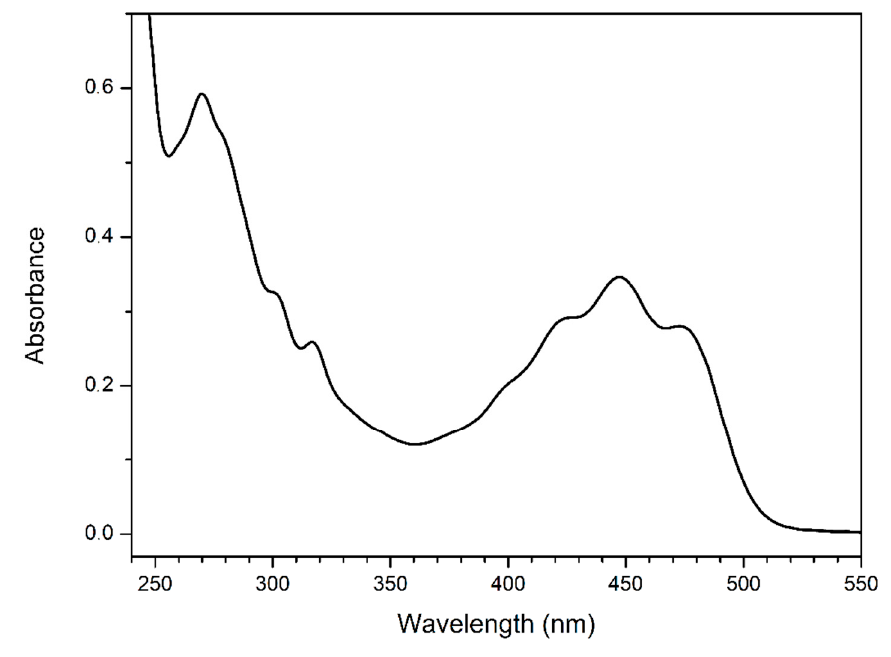
Figure 2. UV–vis absorption spectra of buriti oil diluted in hexane at 5 g/L.